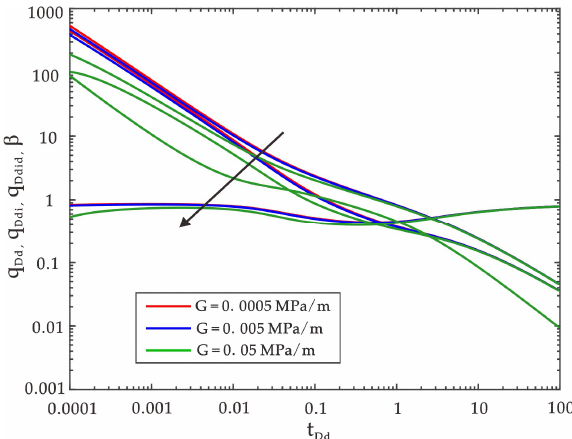
Figure 9. The sensitivity analysis of the threshold pressure gradient in tight reservoirs.